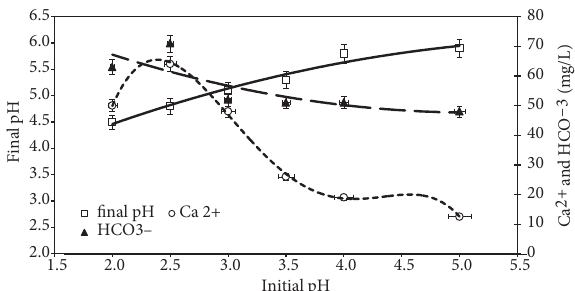
Fig. 4. Effect of initial pH on the release of Ca 2+ and HCO 3– ions from the